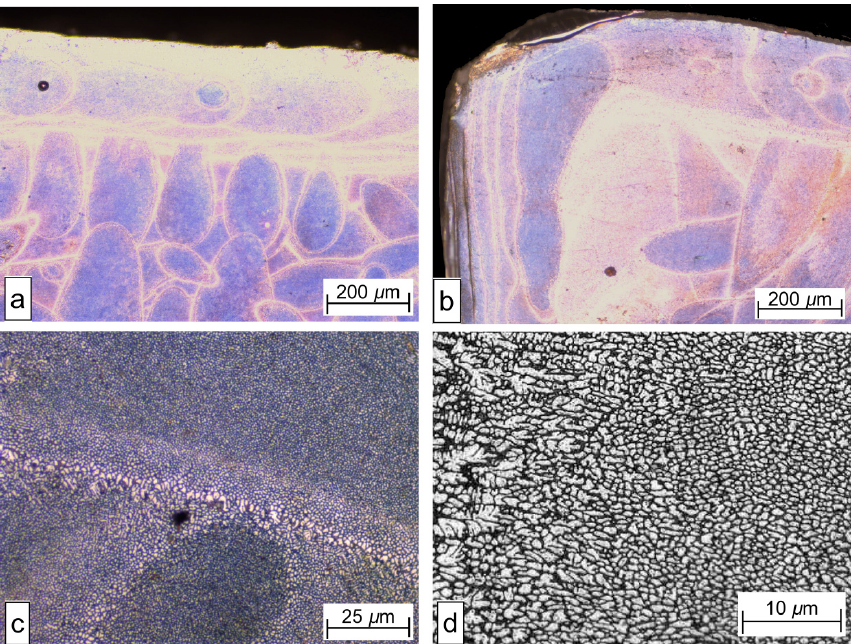
Figure 17. Micrographs of the module wall ( a ), the lattice structure ( b ), the melt pool boundary ( c ), grain microstructure ( d ).